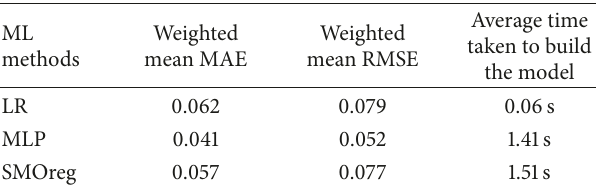
Table 4: Experimental results for 1,500